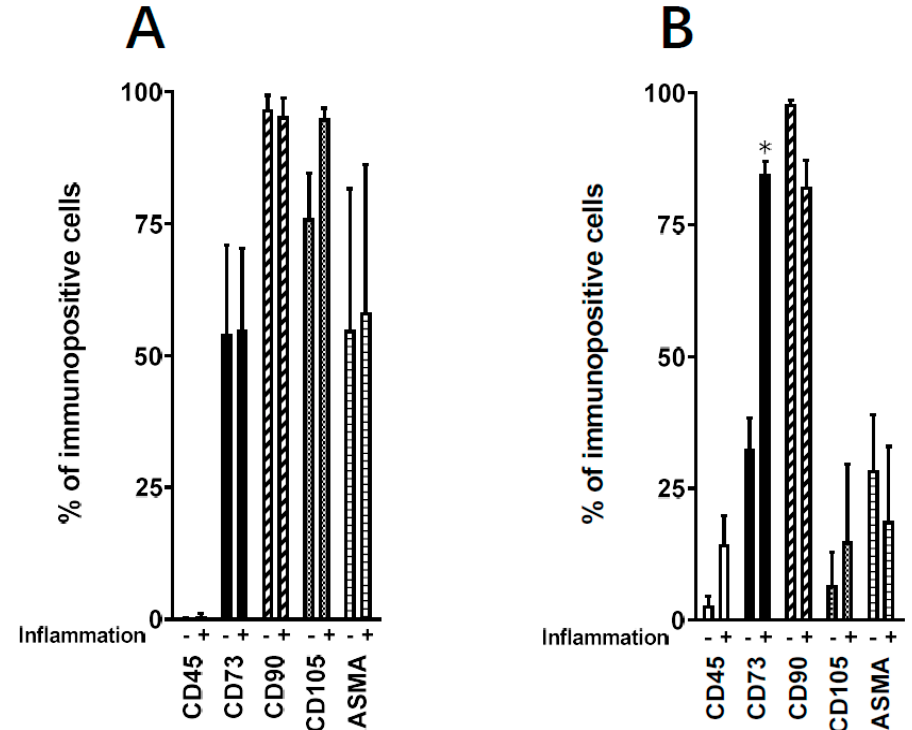
Figure 3. Effect of inflammation on ADHLSC mesenchymal expression profile. Positive expression of mesenchymal cell surface (CD105, CD90, and CD73) and intracellular markers (alpha-smooth muscle